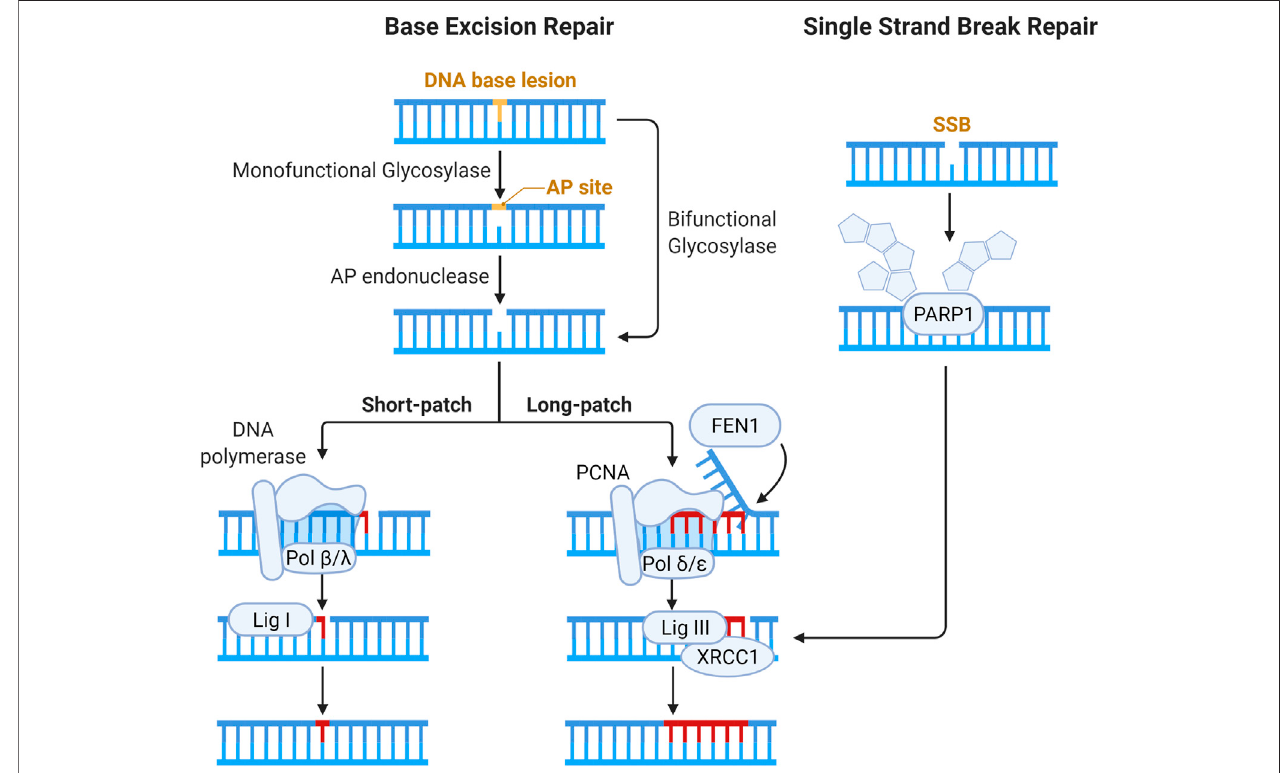
FIGURE 5 | Schematic of pathways for base lesion and single strand break (SSB) repair. Base damage is recognized by a DNA glycosylase and subsequent enzymatic processing generates an abasic site. Abasic sites (also called AP, for apurinic/apyrimidinic sites) are processed by bifunctional DNA glycosylases or AP endonucleases, generatingagap intheDNAstrand thatcanhaveavariety ofends requiringprocessing toenableligation(Kim andWilsonIII2012).Thegapisthen fi lled byPol β orPol λ viashortpatchBER,andthenickisresolvedbyXRCC1-DNALigIIIcomplex(Beard,Prasad,andWilson2006;Lebedevaetal.,2005;Cappellietal., 1997). In long patch BER, Pol δ and Pol ε fi ll in 2 – 12 nucleotides, forming an intermediary fl ap structure that is resolved by fl ap endonucleases (Matsumoto, Kim, and Bogenhagen 1994; Liu, Kao, and Bambara 2004; Wang, Wu, and Friedberg 1993). Flap removal generates SSB which is sealed by DNA ligase I. In direct SSB repair, damage is signaled by the activity of PARP1 (Masson et al., 1998). Gap fi lling and ligation in SSB repair are then accomplished in similar fashion to BER.